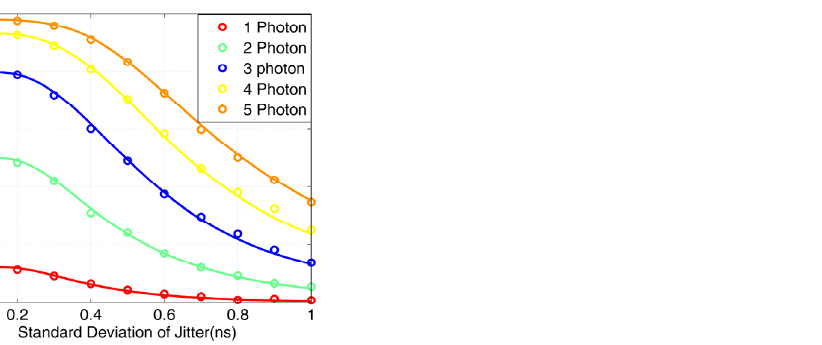
( d ) Figure 6. Monte Carlo simulation verification of correct ranging probability: ( a ) the influence of mean echo photon number and mean pulse count density on correct ranging probability (sequence length 200 μ s, pulse width 1ns, mean noise count density 1 Mcps); ( b ) the influence of sequence length on correct ranging probability (pulse count 1 Mcps, noise count density 1 Mcps, pulse width 1 ns); ( c ) the influence of pulse width on correct ranging probability (sequence length 200 μ s, mean pulse count 1 Mcps); ( d ) the effect of noise count density on detection probability (sequence length 200 μ s, mean pulse count density 1 Mcps, pulse width 1 ns). 4.2. Verify the Correct Ranging Probability Model with Considering System Jitter Figure 7 shows the variation of correct ranging probability with jitter under different mean echo photon number, when the sequence length is 100 μ s, the mean pulse count density is 1 Mcps, the mean noise count density is 1 Mcps, and the pulse width is 1ns. When the FWHM of system jitter is approximately less than half of the pulse width (0.2·2.355 = 0.471 ns), jitter has little effect on the correct ranging probability, but with the increase of jitter, the impact of jitter on correct ranging probability will become extremely significant. It can be seen from Figure 7 that when the jitter is larger than half of the pulse width, the correct ranging probability decreases approximately linearly. In the case of a different mean echo photon number, there is a slight difference in the effect of the jitter on the correct ranging probability. When the mean echo photon number is small, the increase